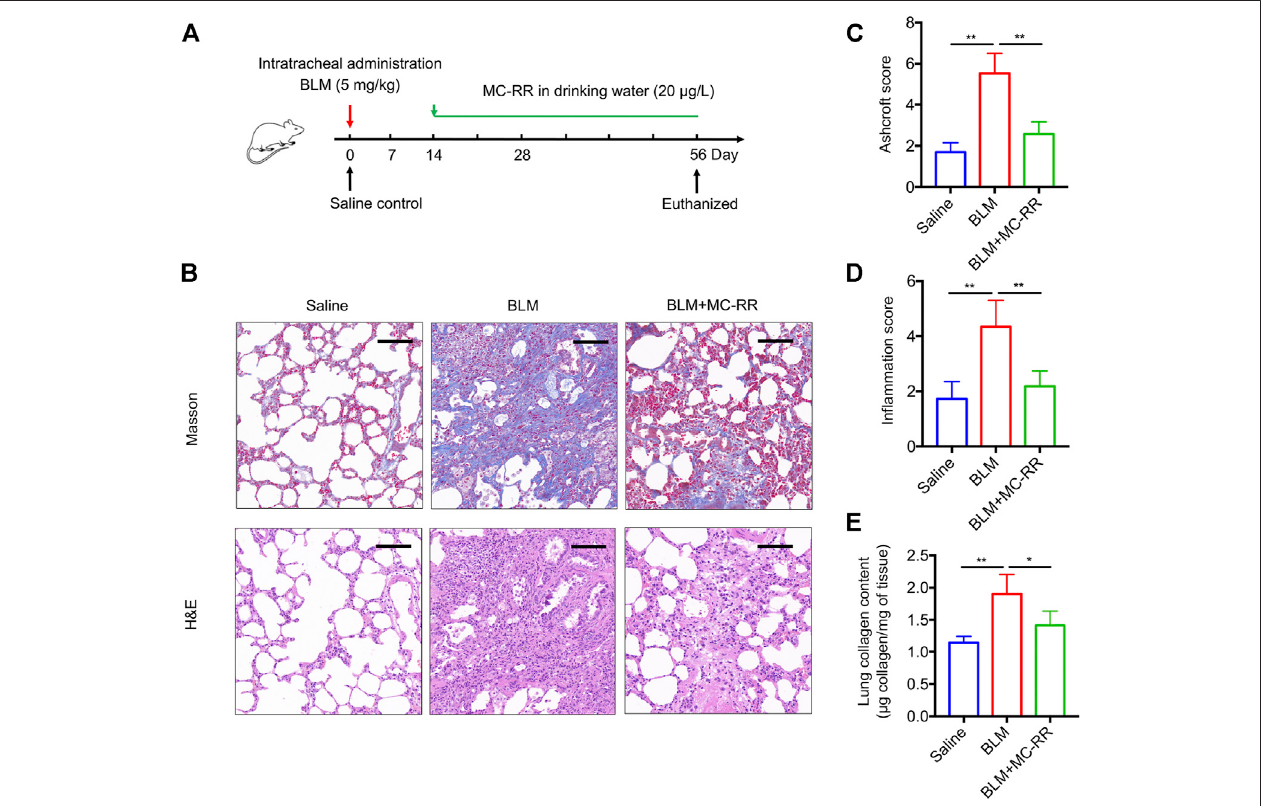
FIGURE1| Microcystin-RR(MC-RR)attenuatesbleomycin(BLM)-inducedpulmonary fi brosis.Ratsreceivedasingleintratrachealinstillationof5.0 mg/kgBLM on day 0. Some of these animals were treated with MC-RR (20 μ g/L) in drinking water on day 14. The control rats received saline intratracheal administration and had distilledwaterfordaily drinking.Rats were euthanized on day 56after BLM instillation, and lungtissuesampleswerecollectedforanalysis. (A) Schematicrepresentation oftheexperimentaldesign. (B) LungtissuesectionswerepreparedandsubjectedtoMasson ’ strichromeandH&Estaining.Scalebar:100 μ m. (C,D) Ashcroftand in fl ammation scores of stained sections of lung tissues were assessed by two pathologists blinded to the study design and are shown as the mean ± SD per group. (E) Lung tissuecollagen contentswere measured by ahydroxyproline assay. Dataare expressed asmean ± SD. * p < 0.05, ** p < 0.01 determined byone-wayANOVAwith S-N-K post-hoc analysis. Each group had fi ve